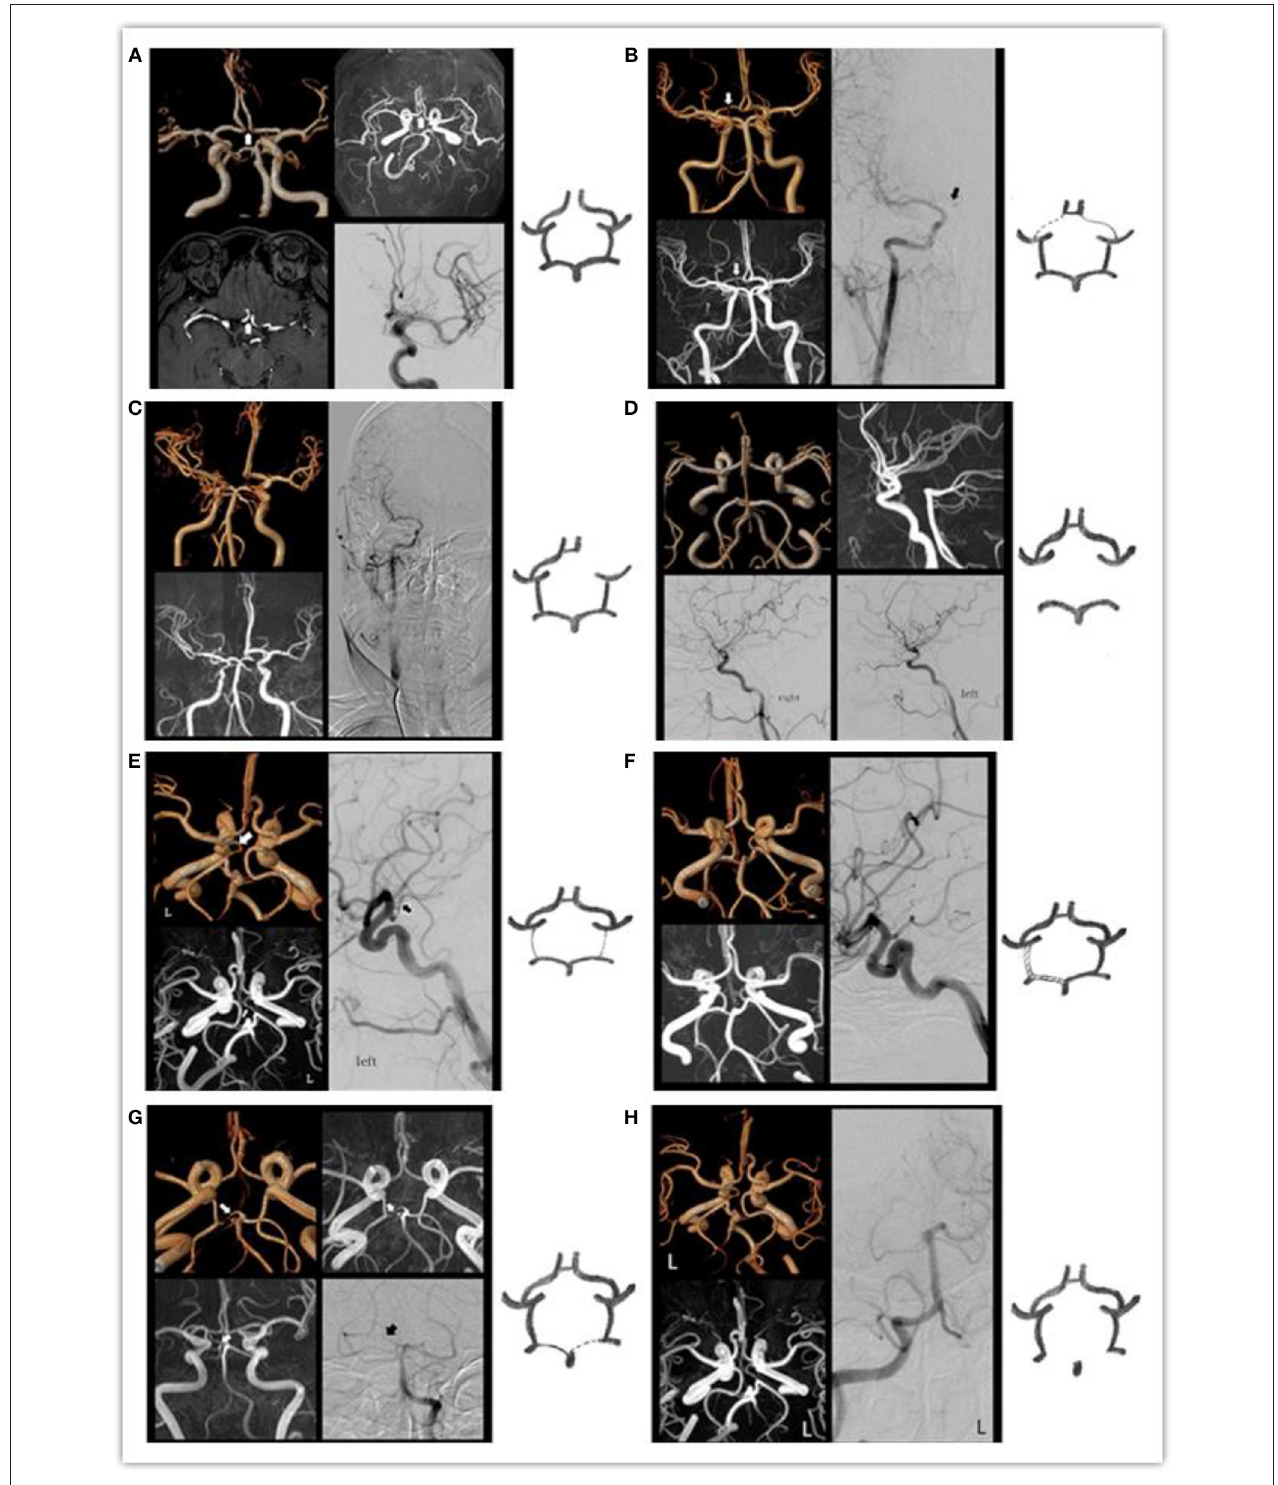
FIGURE 2 | The MRA and DSA of the various types of the circle of Willis: (A) arrow indicates absent ACOA. (B) Arrow indicates right slim A1. (C) Absent right A1. (D) Absent bilateral PCOAs. (E) Arrow indicates left slim PCOA. (F) Bilateral PCOAs = P1 > 1mm. (G) Arrow indicates he right slim P1. (H) Absent right P1.